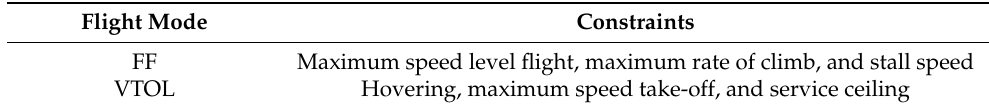
Table 4. Performance constraints for multi-mode constraint analysis. Flight Mode Constraints FF Maximum speed level flight, maximum rate of climb, and stall speed VTOL Hovering, maximum speed take-off, and service